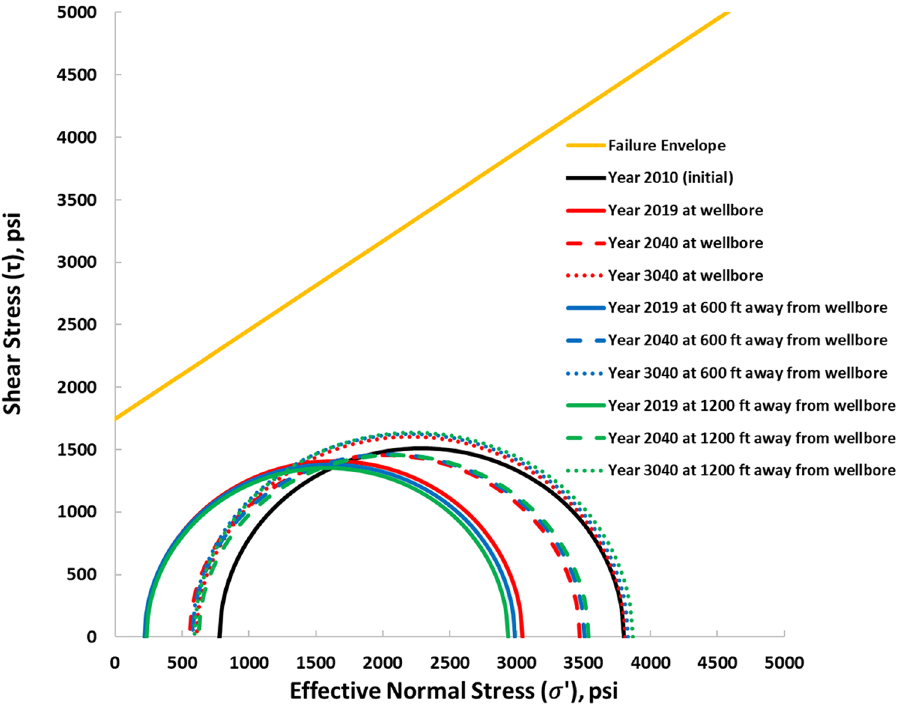
Figure 16. Mohr circles depicting the stress changes within the reservoir (Layer 6) when 5500 psi BHP injection pressure was used.